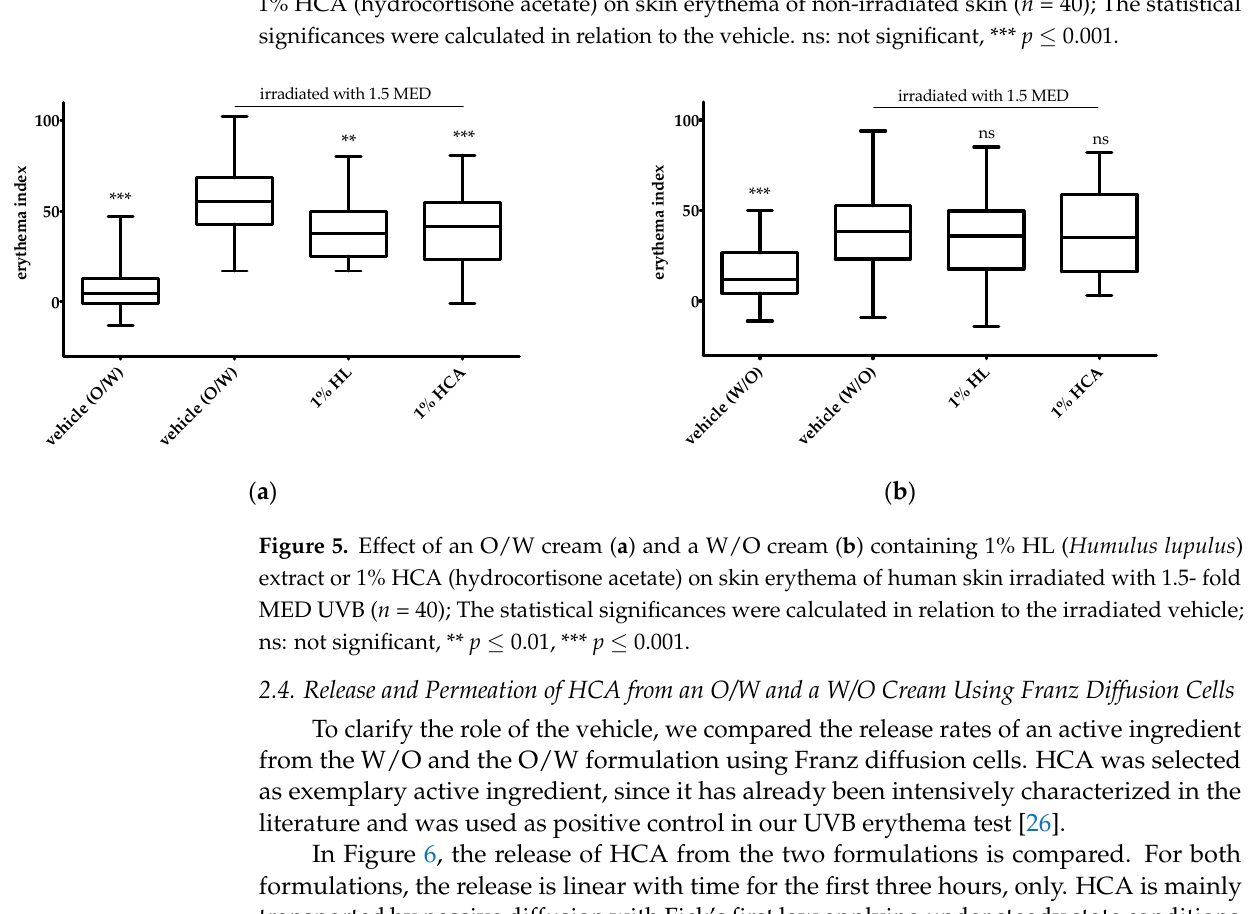
Figure 4. Effect of an O/W cream ( a ) and a W/O cream ( b ) with 1% HL ( Humulus lupulus ) extract or 1% HCA (hydrocortisone acetate) on skin erythema of non-irradiated skin ( n = 40); The statistical significances were calculated in relation to the vehicle. ns: not significant, *** p ≤ 0.001.